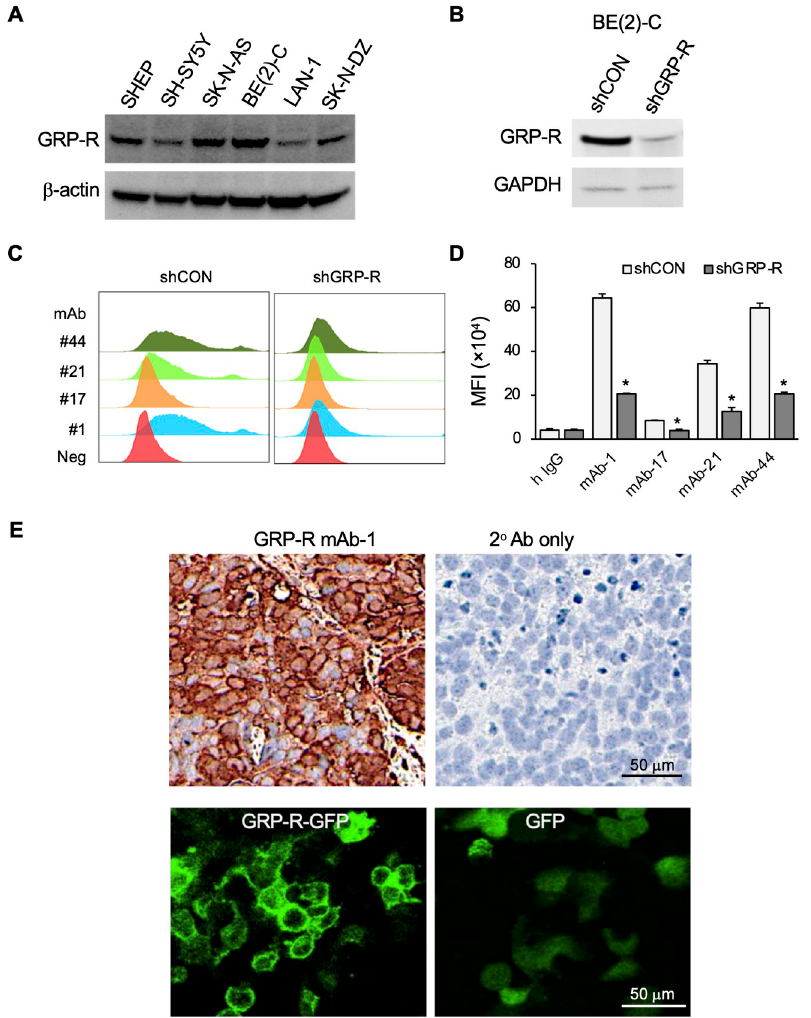
Fig 2. Evaluation of GRP-R mAb binding affinity with neuroblastoma cells and tissue. (A) GRP-R expression was detected by immunoblotting in six human neuroblastoma cell lines. β -actin was used for protein loading control. (B) GRP-R knock down with shRNA was confirmed with immunoblotting. GAPDH was used for protein loading control. (C) The antibody binding assay was carried out with control cells BE(2)-C/shCON and GRP-R knockdown cells BE (2)-C/shGRP-R by flow cytometry. Total cell number 5 × 10 5 was analyzed. Primary antibody concentration was 25 μ g/ml. Secondary antibody (tagged with Alexa Fluor 488) concentration was 5 μ g/ml. (D) The mean fluorescence intensity (MFI) in BE(2)-C/shCON and shGRP-R cells was quantified. (E) Immunohistochemical staining on neuroblastoma PDX tissue with GRP-R mAb-1, showed the specific staining of GRP-R on cytoplasmic membrane (dark brown on the cytoplasmic membrane, top left), and the absence of staining of negative control with secondary antibody only (top right). Exogenously expressed GRP-R-GFP was localized on cytoplasmic membrane (bottom left) and GFP alone was non-specifically distributed in